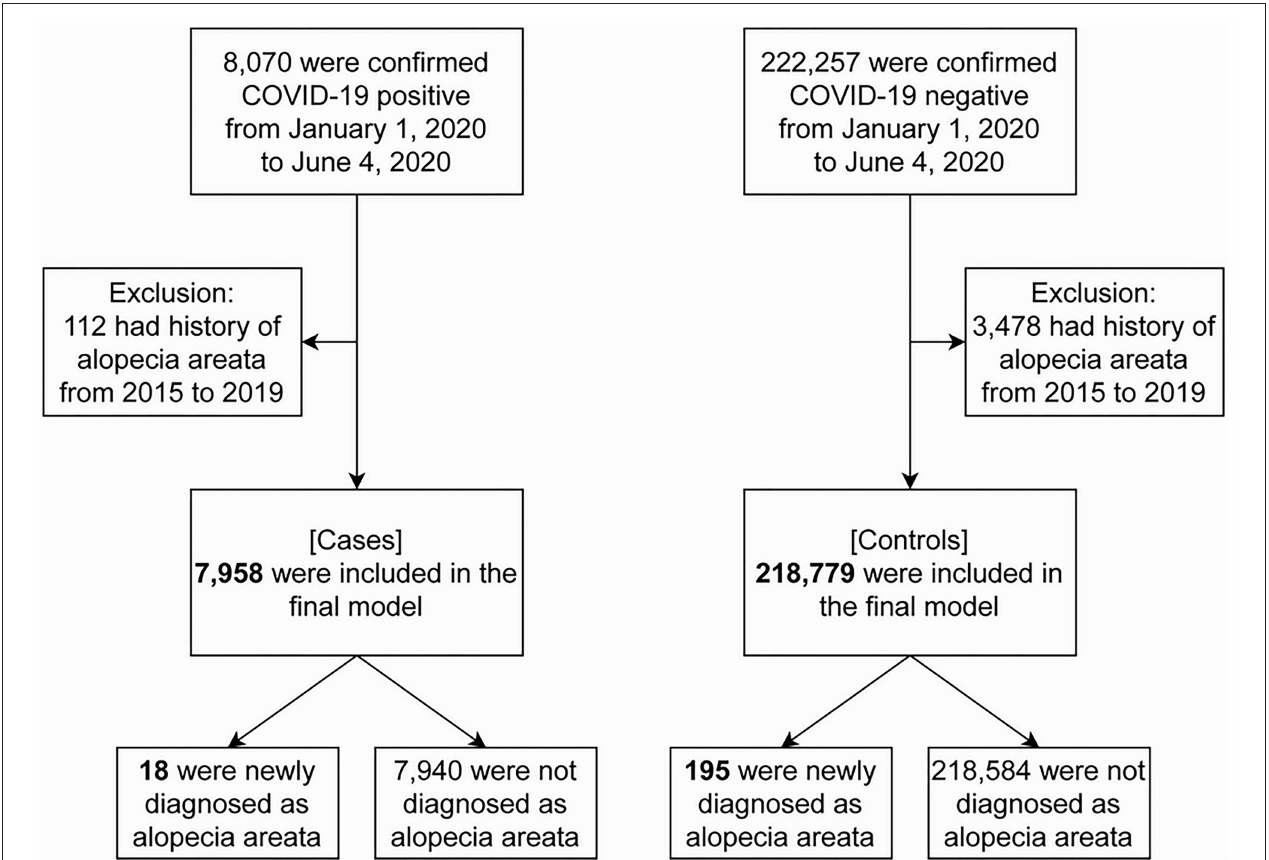
FIGURE 2 | Flowchart of study subject selection. Alopecia areata was diagnosed with L63 in ICD-10-Code. COVID-19, coronavirus disease 2019.